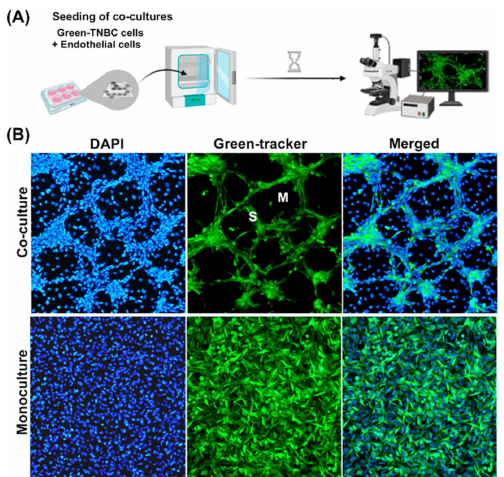
Figure 1. Characterization of the co-culture model of TNBC cells with endothelial cells. ( A ) Illustration of the vasculogenic mimicry process in vitro. TNBC cells stained with a green tracker were seeded with endothelial cells (1:1) and allowed to interact for 2 days. The formation of cord-like networks was evaluated with epifluorescence microscopy. ( B ) MBCDF-T cells stained with a green cell fluorescent tracker were incubated in the presence (upper panels, co-cultures) or the absence (lower panels, monocultures) of unstained endothelial cells (EA.hy926). Afterwards, cells were fixed with ethanol. A mounting medium containing DAPI was used to label cell nuclei in blue (left panels). TNBC cells- vasculogenic mimicry was identified only in co-cultures by the formation of meshes (M) and segments (S) stained in green (upper panels). Merged pictures are shown in right panels. Magnification is 10 ×